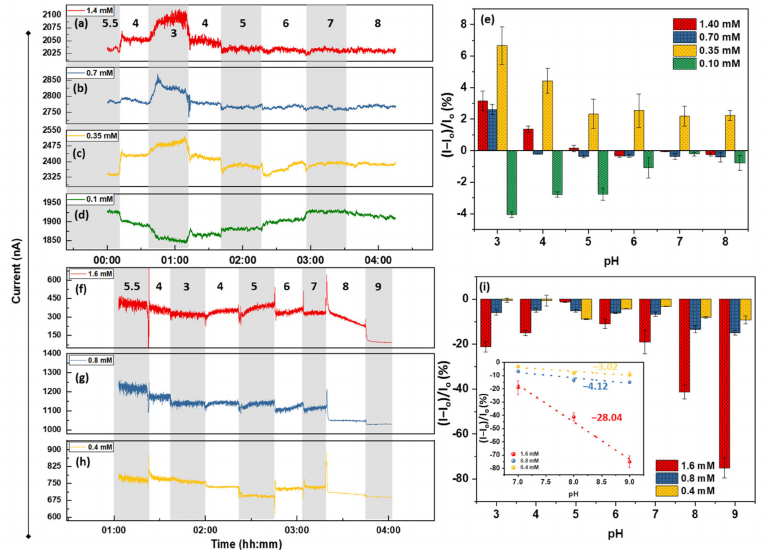
Figure 6. Sensing performance of 8 h annealed FLG functionalized by ( a ) 1.4 mM (I o = 2035 nA), ( b ) 0.7 mM (I o = 2775 nA), ( c ) 0.35 mM (I o = 2330 nA), and ( d ) 0.1 mM (I o = 1927 nA) of Py-NH 2 . ( e ) Graph represents the calibration curve of the Py-NH 2 -functionalized sensors. The sensing perfor- mance of 8 h annealed FLG functionalized with ( f ) 1.6 mM (I o = 385 nA), ( g ) 0.8 mM (I o = 1220 nA), and ( h ) 0.4 mM (I o = 764 nA) of Py-OH. ( i ) The calibration bar graph of the sensors demonstrating the maximum pH response at pH around -OH pKa (8.7). The error bars represent average ± standard deviation of the last two minutes of the chemiresistive response (3 samples